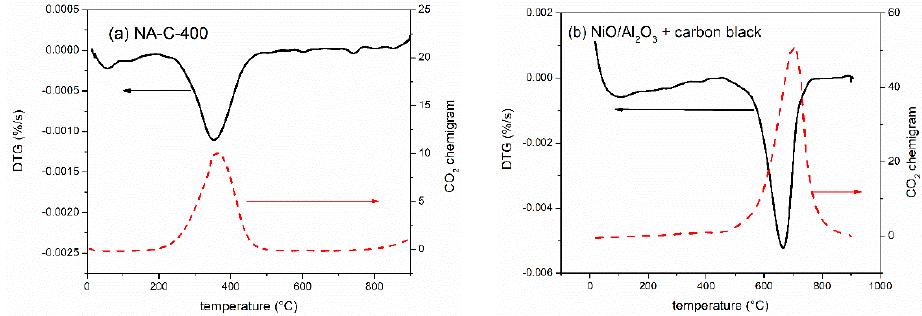
Figure 4. TPO results of ( a ) NA–C–400 and ( b ) fresh NiO/Al 2 O 3 mixed with carbon black in an air flow at a heating rate 5 °C/min.